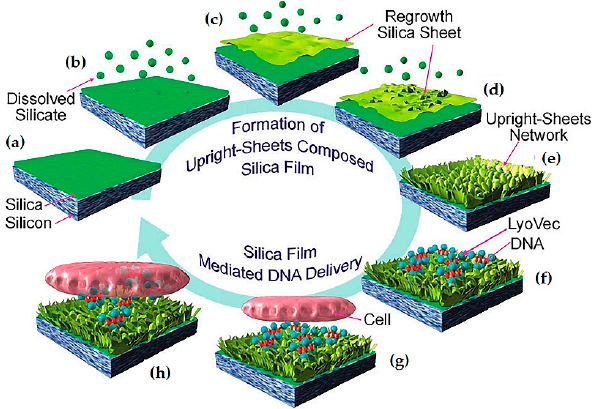
mediated DNA transfection to the cell ( f – h ) (reproduced from [30] with permission from The Royal Society of